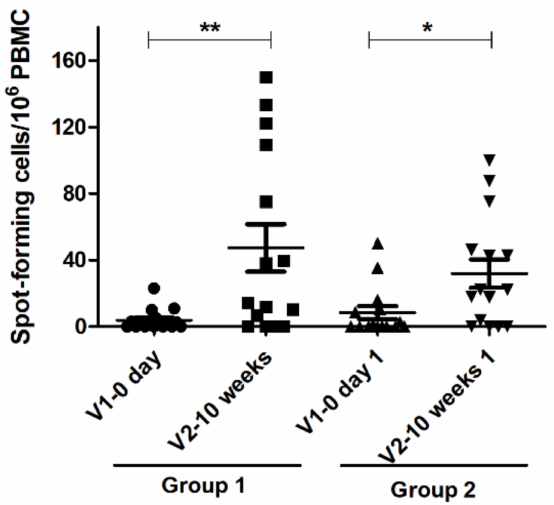
Figure 4. ELISpot analysis for interferon gamma (IFN- γ ) secreting peripheral blood mononuclear cells (PBMC) from immunized horses. PBMC were collected from G1 and G2 horses before (day 0 = V1; G1: black circles; G2: upright black triangles) and after (10 weeks = V2; G1: black squares; G2: downright black triangle)) booster immunization. PBMC were isolated and stimulated with EIV. The response is presented as IFN- γ positive spot-forming cells per 10 6 PBMC. The central line in the scattered dot plot indicates the mean of the data with standard error of mean (error bars). * p < 0.05; ** p < 0.01 using 2-way repeated measures ANOVA with Tukey’s multiple comparisons